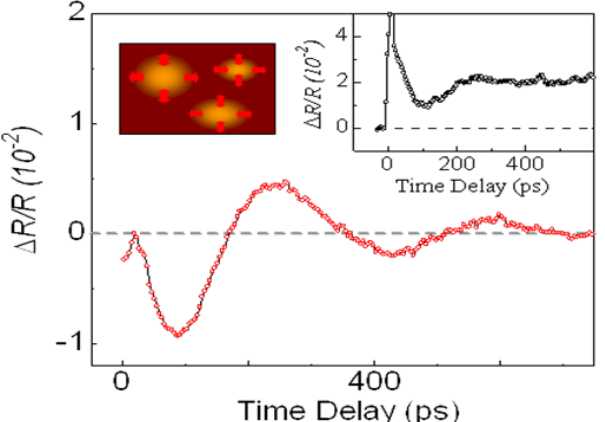
Figure 21. Time evolutions of  R / R (inset) and the oscillating component detected at 0.31 eV for the slow time domain, together with a schematic illustration of the oscillating photoinduced metallic